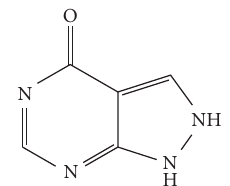
Figure 1: Structure of